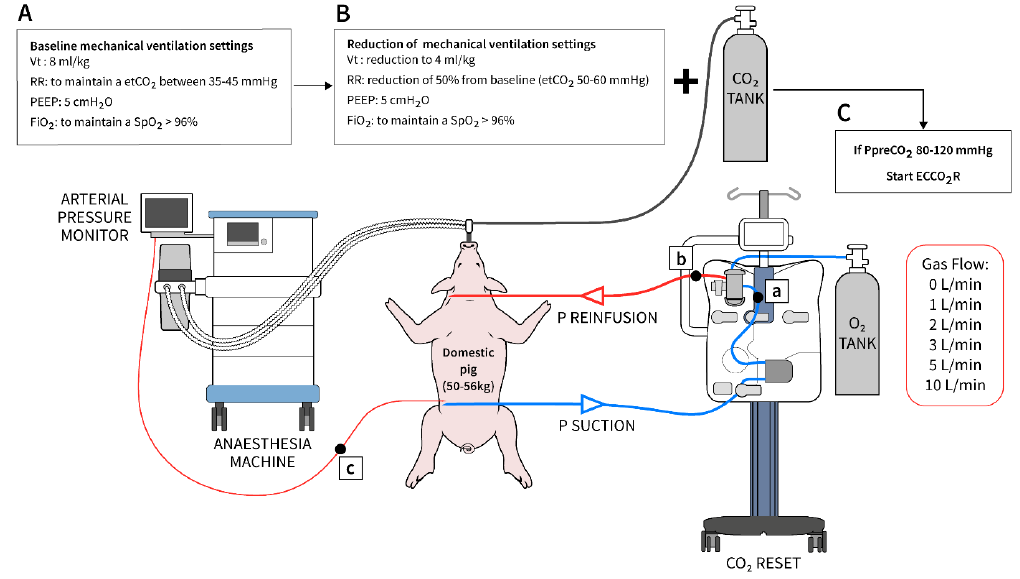
Figure 2. Diagram showing the experiment steps ( A → C ). a: sampling site pre-membrane lung; b: sampling site post-membrane lung; and c: arterial sampling site.